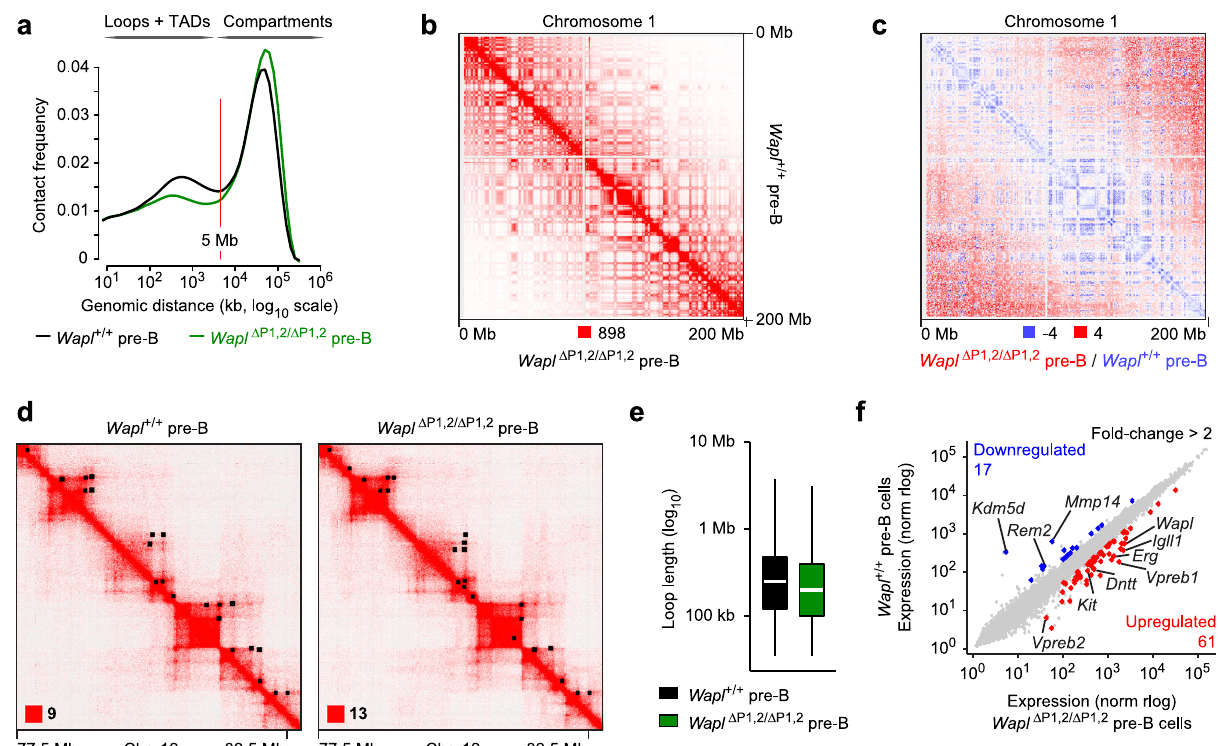
Fig. 2 | Minor differences in the chromosomal architecture of Wapl +/+ and Wapl Δ P1,2/ Δ P1,2 pre-Bcells.a Frequencydistributionofintrachromosomalcontactsas a function of the genomic distance using logarithmically increased genomic dis- tance bins, determined by Hi-C analysis of ex vivo sorted Wapl +/+ (black) and Wapl Δ P1,2/ Δ P1,2 (green) pre-B cells using HOMER (see Methods). b Hi-C contact matrices of chromosome 1, determined for ex vivo sorted Wapl +/+ and Wapl Δ P1,2/ Δ P1,2 pre-B cells and plotted at a 500-kb bin resolution with Juicebox 74 . The intensity of each pixel represents the normalized number of contacts between a pair of loci 5 . The maximum pixel intensity is indicated below (red square). c Differential Hi-C contactmatrixofchromosome1displayingthedifferenceinpixelintensitybetween Wapl +/+ pre-B and Wapl Δ P1,2/ Δ P1,2 pre-B cells as the ratio ( Wapl Δ P1,2/ Δ P1,2 )/( Wapl +/+ ). More interactions (blue) in the TAD range were observed for Wapl +/+ pro-B cells, while more interactions (red) in the compartment range were detected for Wapl Δ P1,2/ Δ P1,2 pre-B cells. d Hi-C contact matrices of a zoomed-in region on chromosome 12